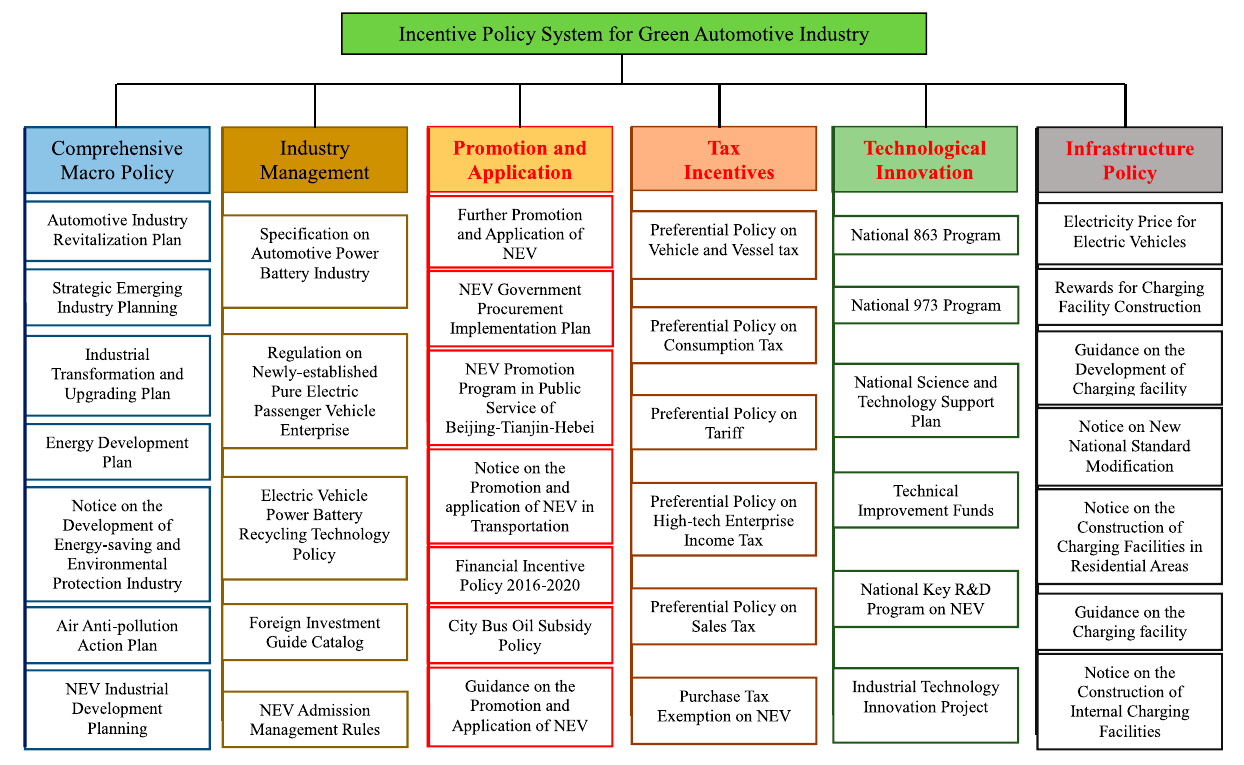
FIGURE 1 | Incentive policy system for green automotive